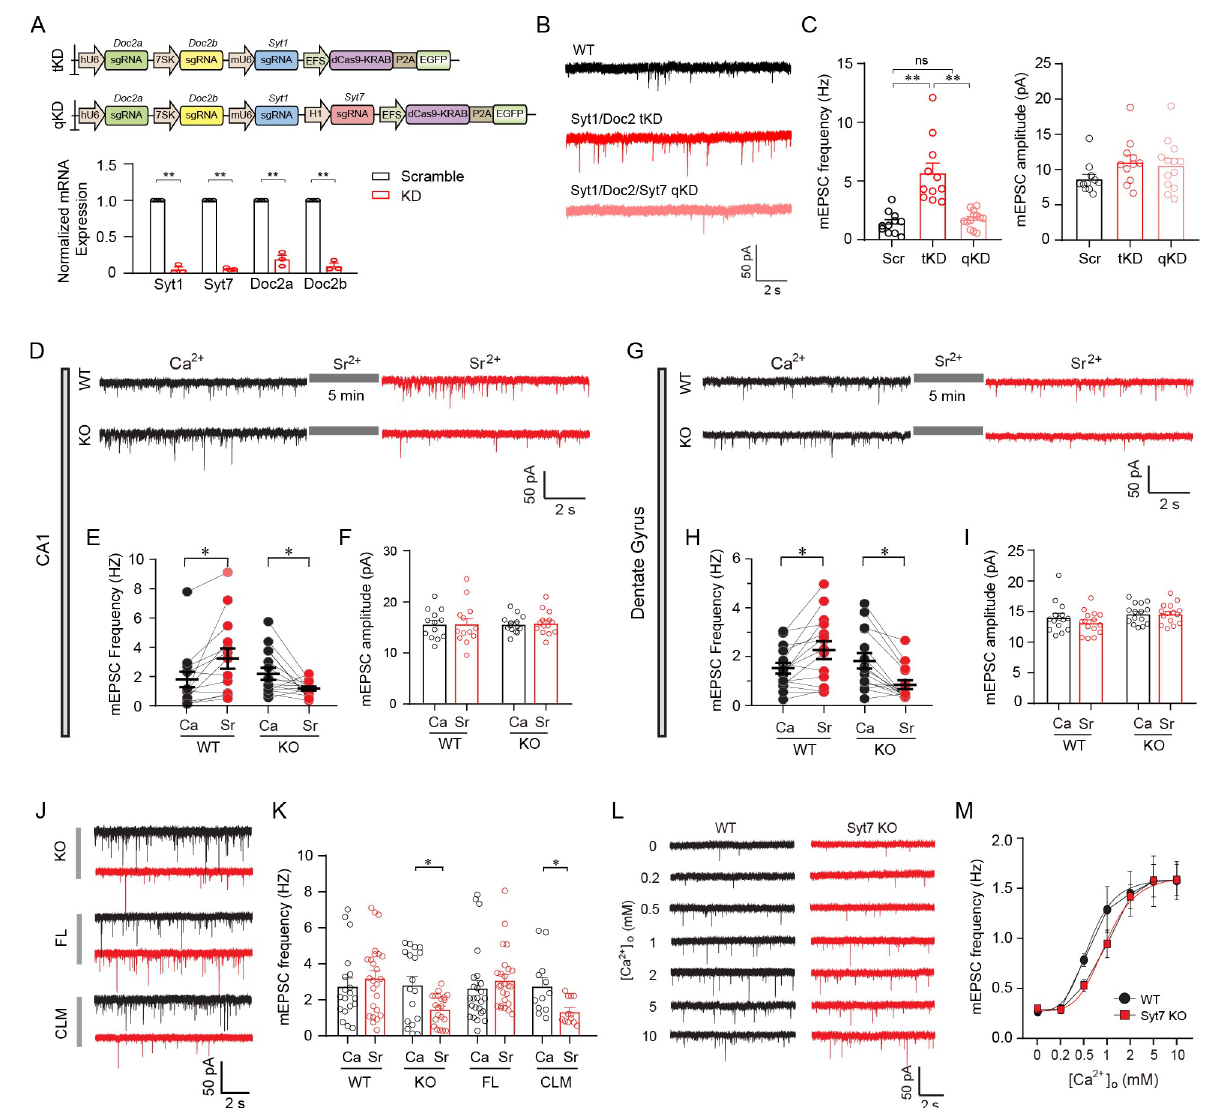
Fig 1. Syt7 triggers spontaneous neurotransmitter release. ( A ) Design of multiplex CRISPRi system. Upper, schematic illustration of the multiple gene targeting CRISPRi for Syt1/Doc2a/2b and Syt1/Syt7/Doc2a/2b. Lower, qRT-PCR analysis of mRNA expression of hippocampal neurons with multiplex KD of Syt1/Syt7/Doc2a/2b. ( B ) Sample traces of mEPSCs recorded in cultured hippocampal neurons with multiplex gene KD. ( C ) Quantification of the frequency (left) and amplitude (right) of mEPSCs. WT, n = 11; tKD, n = 11; qKD, n = 13. ( D ) Representative traces of mEPSCs recorded from hippocampal CA1 slices. The same neuron was recorded in the presence of extracellular Ca 2+ or Sr 2+ in the ACSF solution with a 5-min interval. ( E ) Paired comparison of the frequency of Ca 2+ - and Sr 2+ -triggered mEPSCs in hippocampal CA1 slices. WT, n = 13; KO, n = 14. ( F ) Bar graph of mEPSC amplitude. ( G–I ) Sample traces ( G ) and quantification of frequency ( H ) and amplitude ( I ) of mEPSCs recorded in the DG slices. WT, n = 15; KO, n = 15. ( J ) Representative traces of Ca 2+ - or Sr 2+ -triggered mEPSCs recorded from cultured WT hippocampal neurons, Syt7 KO neurons, and KO neurons expressing Syt7 FL or Syt7 CLM . ( K ) Quantitative analysis of the frequency of mEPSCs. WT, n = 19 for Ca 2+ , n = 25 for Sr 2+ ; Syt7 KO, n = 18/21; KO + Syt7 FL , n = 25/25; KO + Syt7 CLM , n = 12/12. ( L ) Representative traces of mEPSCs recorded from WT and Syt7 KO neurons in a Ca 2+ gradient from 0 mM to 10 mM. ( M ) Quantitative analysis of mEPSC frequency recorded in Ca 2+ gradient. Red curves are fitted Hill function. Ca 2+ affinity: WT, 1.52 ± 0.53; KO, 1.35 ± 0.52; P = 0.819. Ca 2+ cooperativity: WT, 0.46 ± 0.11; KO, 0.77 ± 0.24; P = 0.258. WT, n = 13–19; Syt7 KO, n = 16–20. Student t test; � P < 0.05; �� P < 0.001; error bars, SEM. The numerical data underlying this figure are included in S1 Data. CLM, calcium ligand mutant; CRISPRi, CRISPR interference; DG, dentate gyrus; FL, full-length; KD, knockdown; KO, knockout; mEPSC, miniature excitatory postsynaptic current; qKD, quadra KD; qRT-PCR, quantitative reverse transcription PCR; Syt7, synaptotagmin-7; tKD, triple KD; WT, wild-type.